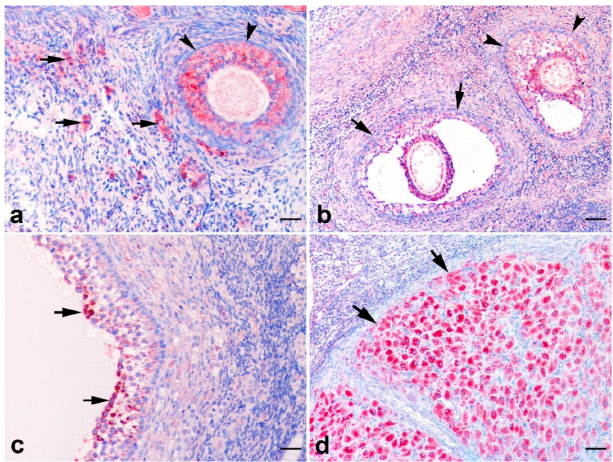
Figure 5. AMH immunopositivity in the feline ovary. ( a ) AMH immunopositivity in granulosa cells of secondary follicles (arrow heads) and interstitial luteal cells (arrows); ( b ) AMH immunopositiv- ity in granulosa cells of early antral follicles (arrow heads) and antral follicles (arrows), ( c ) AMH immunopositivity in mural granulosa cells of large antral follicles (arrows); ( d ) AMH immunoposi- tivity in luteal cells of corpus luteum (arrows). SABP immunostaining, AEC chromogen, Mayer’s hematoxylin counterstaining, ( a , c ) × 280 and ( b , d ) × 140. Scale bar: ( a , c ) = 30 µ M and ( b , d ) = 60 µ